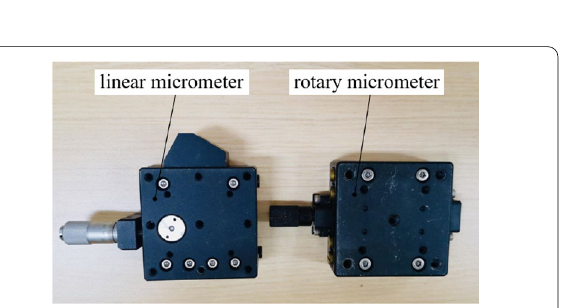
Figure 19 Experimental prototype of REMC-NFM